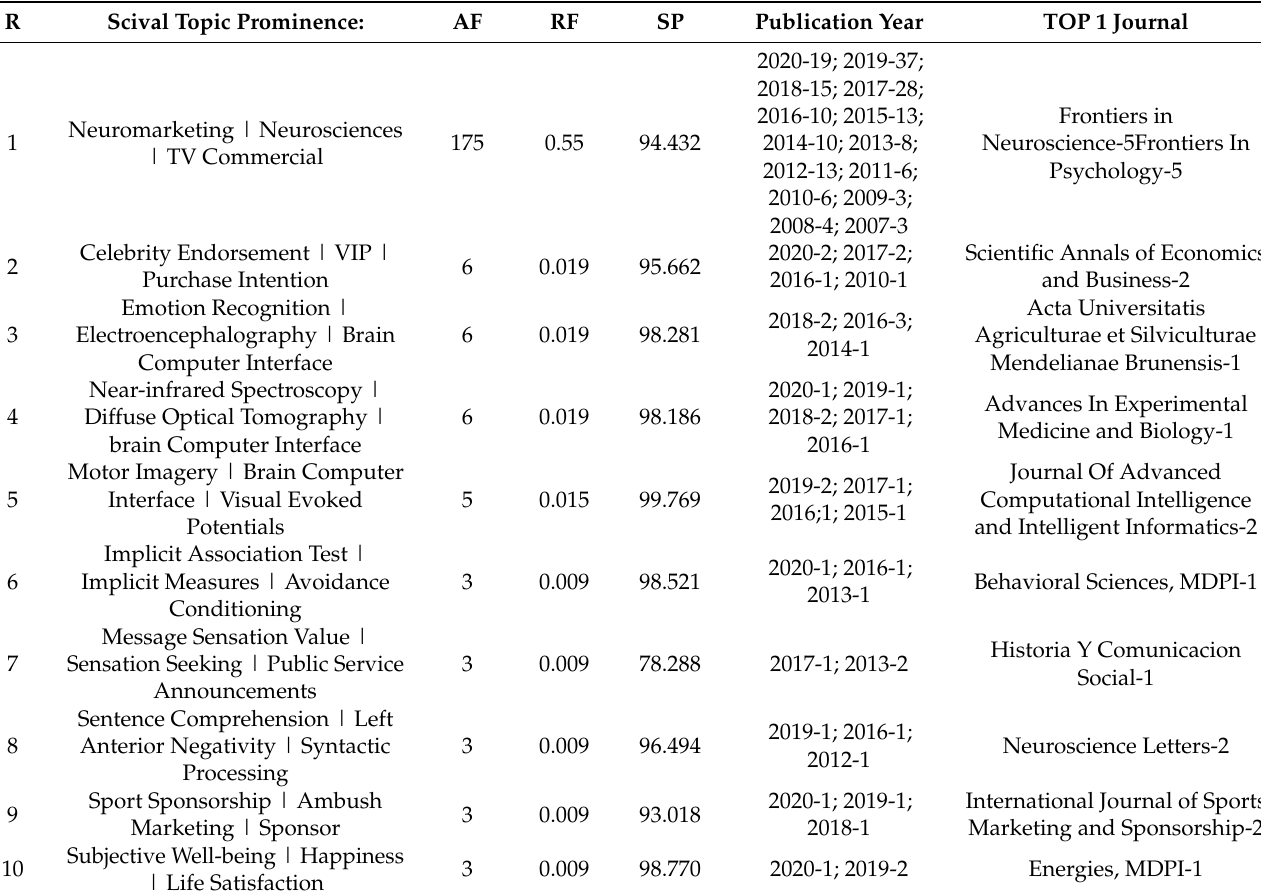
Table 7. Top ten: Scival Topic